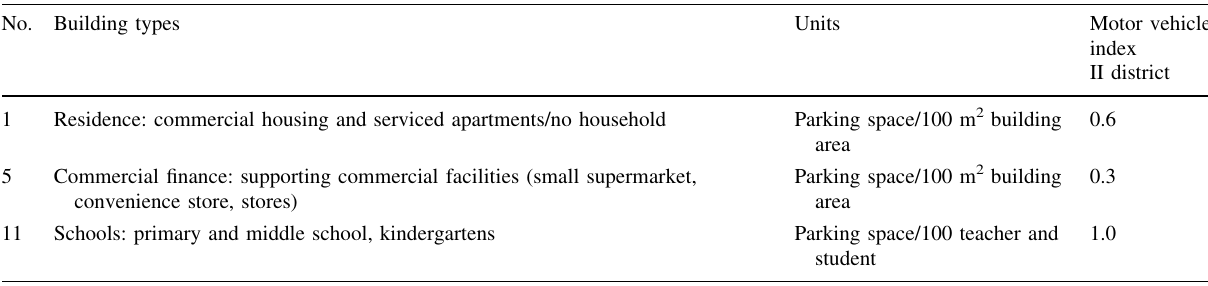
Table 5 Part of Xuzhou City vehicle standard parking match